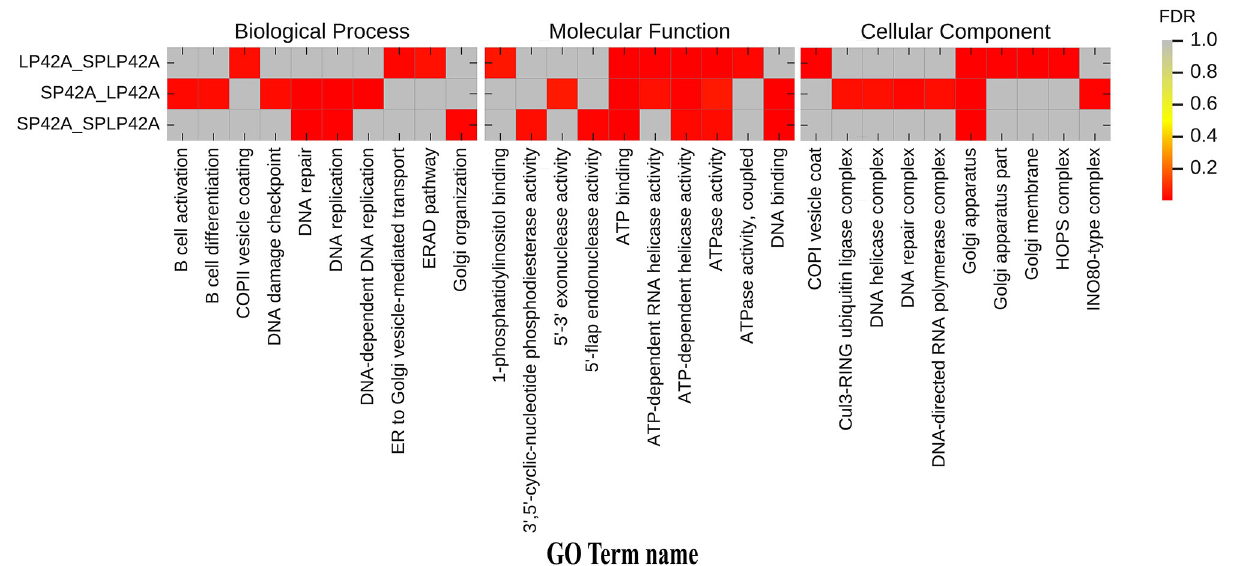
followed by exon and intergenic and the type of intronic RNA accounts for more than 56.8% (46). Therefore, lncRNAs were tissue- and species-specific